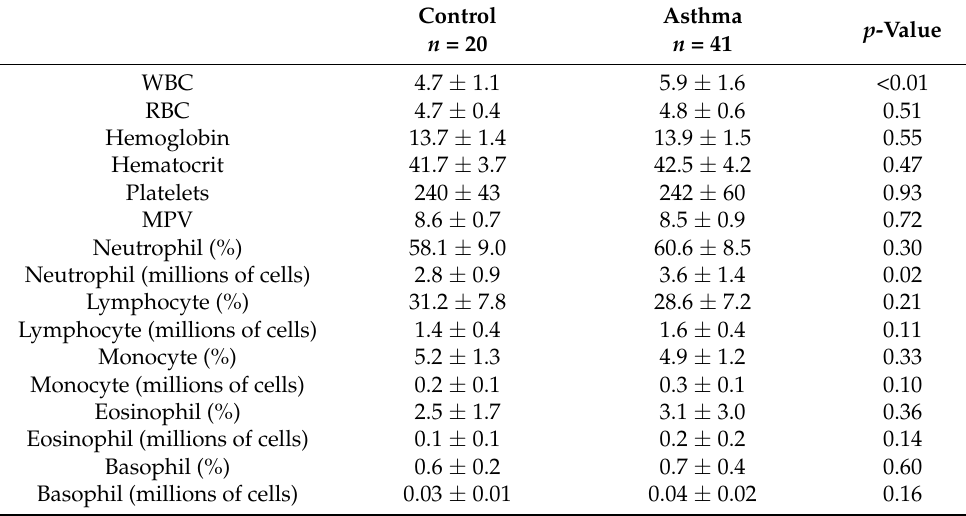
Table 6. Blood Chemistry and Immune